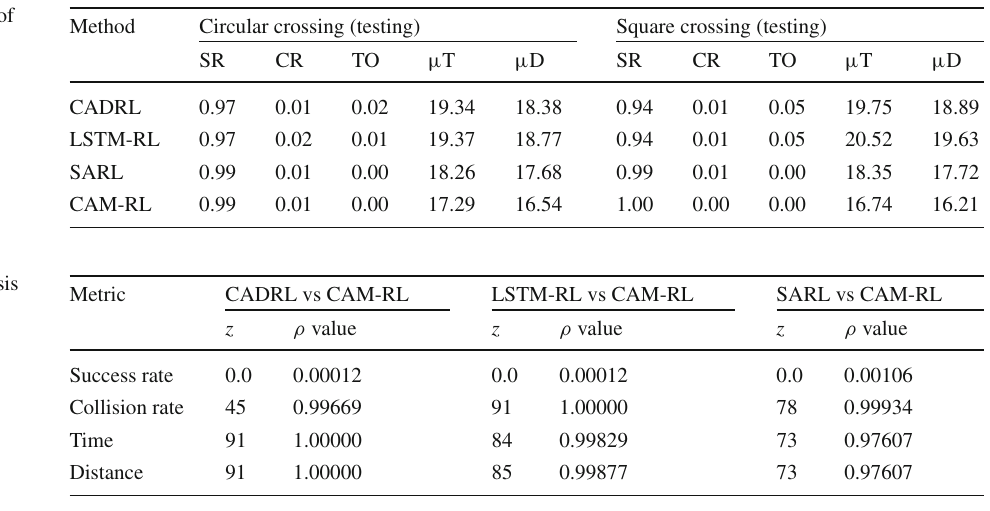
Table 4 Quantitative results of robot navigation in circular crossing and square crossing scenarios with five humans